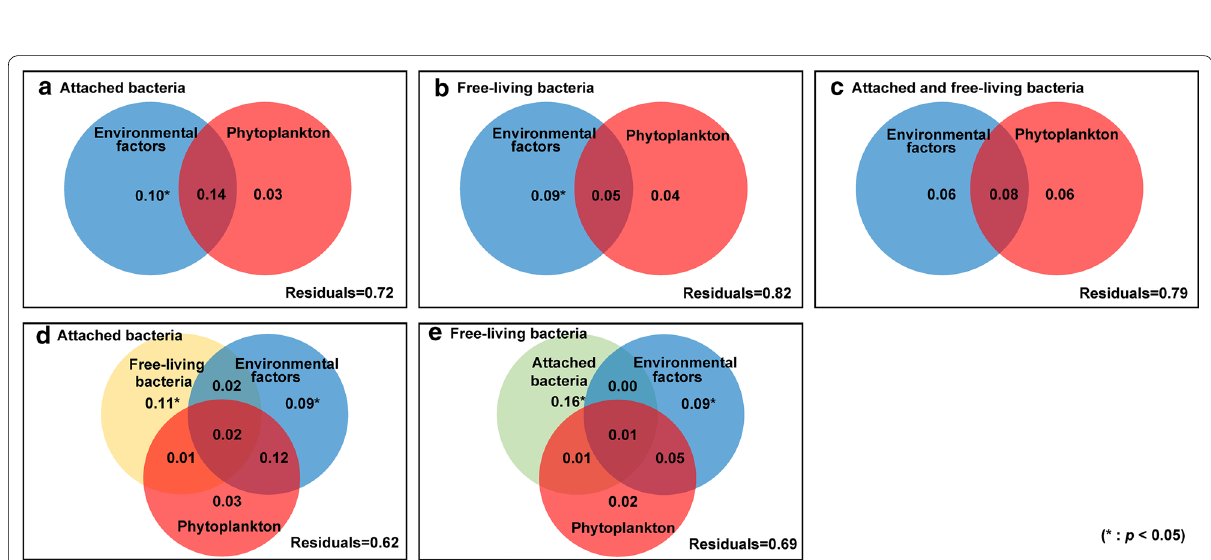
Fig. 5 Variation partitioning in redundancy analysis ordination of phytoplankton genera, bacterial families, and environmental parameters. a Attached bacterial families with environmental parameters and phytoplankton genera; b free-living bacterial families with environmental parameters and phytoplankton genera; c bacterial families with environmental parameters and phytoplankton genera; d attached bacterial families with free-living bacterial families, environmental parameters and phytoplankton genera; e free-living bacterial families with attached bacterial families, environmental parameters and phytoplankton genera. (Starred numbers indicate the level of